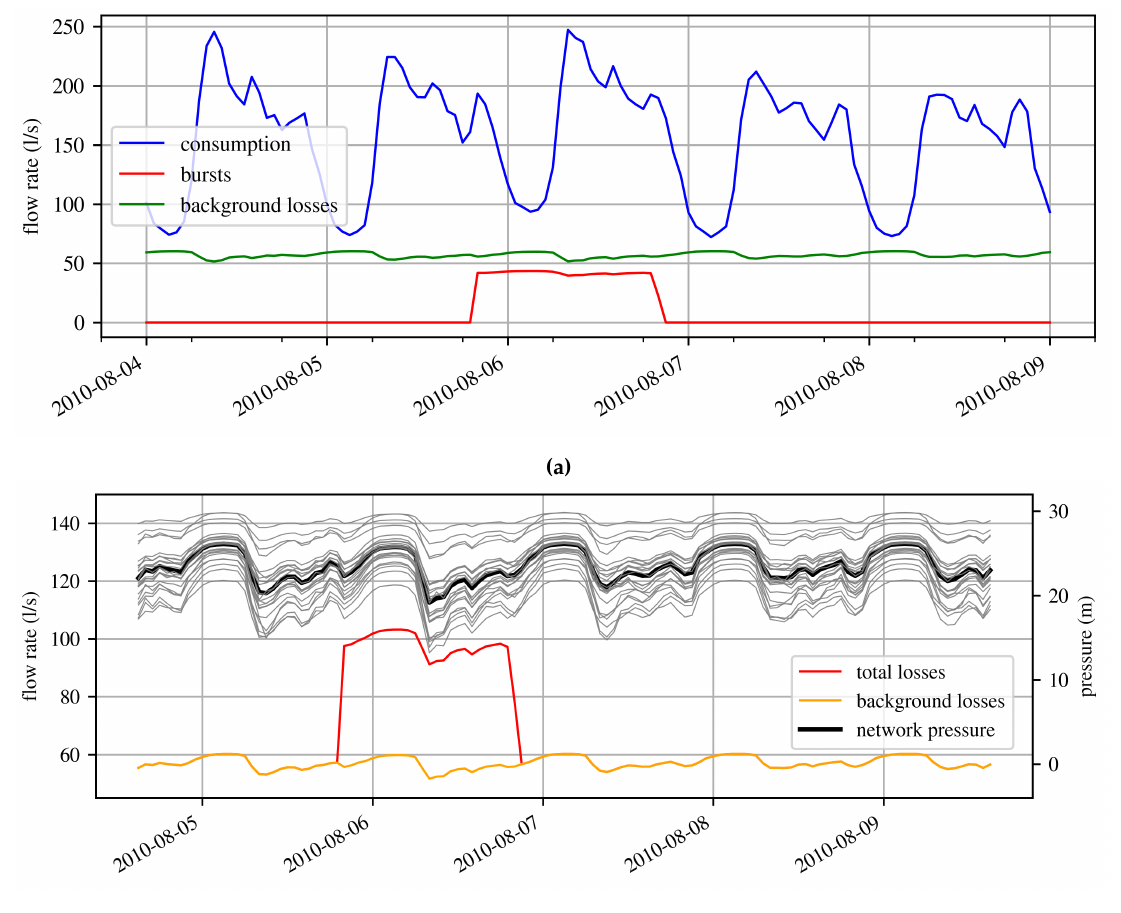
Figure 5. Detail of simulated bursts in the Apulian network. Fig. 5a shows a burst event with its consumption behaviour, while Fig. 5b depicts the water losses (burst and background leaks) and the pressure of each network nodes with also the average network pressure.